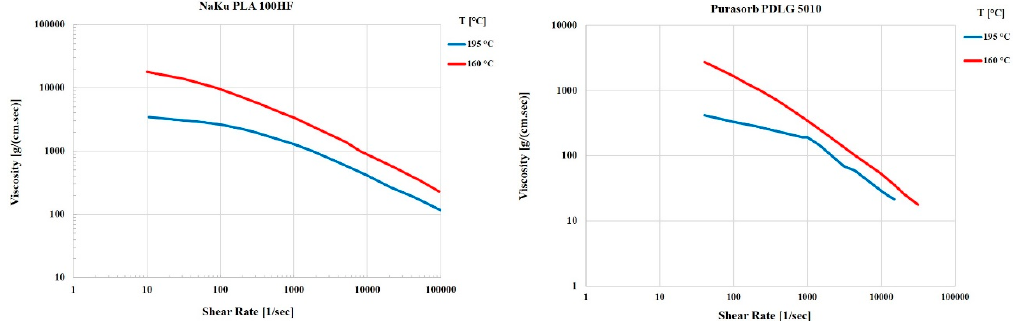
Figure 6. Comparison of the rheological behavior of NaKu PLA 100HF (left) and Purasorb PDLG 5010 (right).